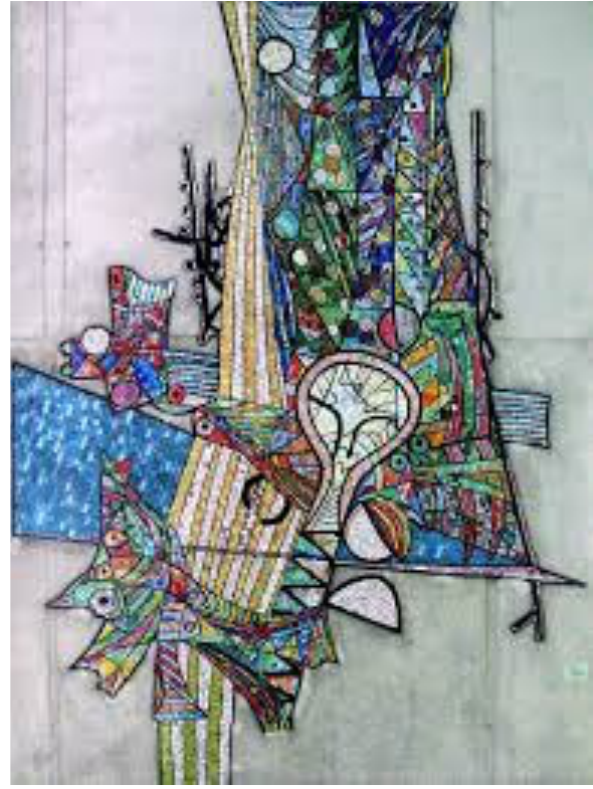
Figure 3 | Heinz Trökes, Glass mosaic for a school in Hamburg. 1957.